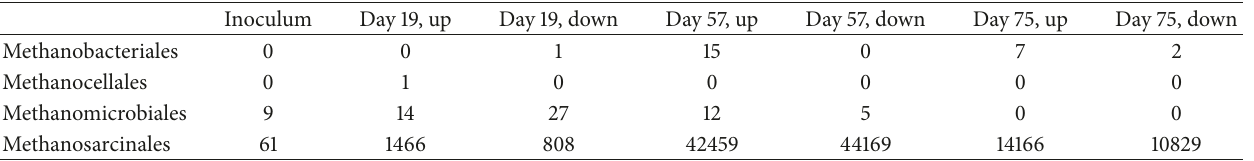
Table 2: Total number of reads related to the identified methanogenic species during the course of AD of microalgae and sodium acetate. “Up” and “down” labels next to the day of sampling refer to the upper or bottom part of the sampled sludge bed. Data is combined for both